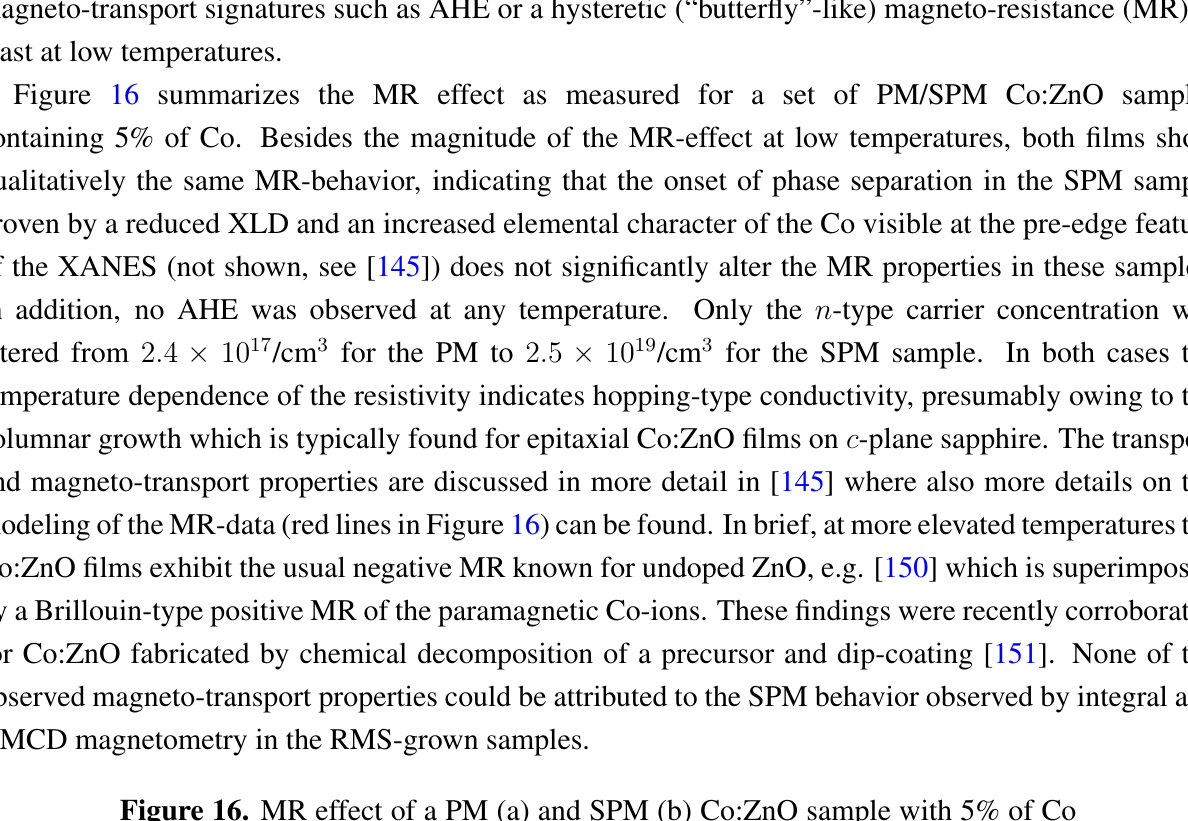
Figure 16. MR effect of a PM (a) and SPM (b) Co:ZnO sample with 5% of Co measured in van-der-Pauw geometry from 5 K to 300 K applying the magnetic field parallel to the c -axis. Red lines are fitting curves, see